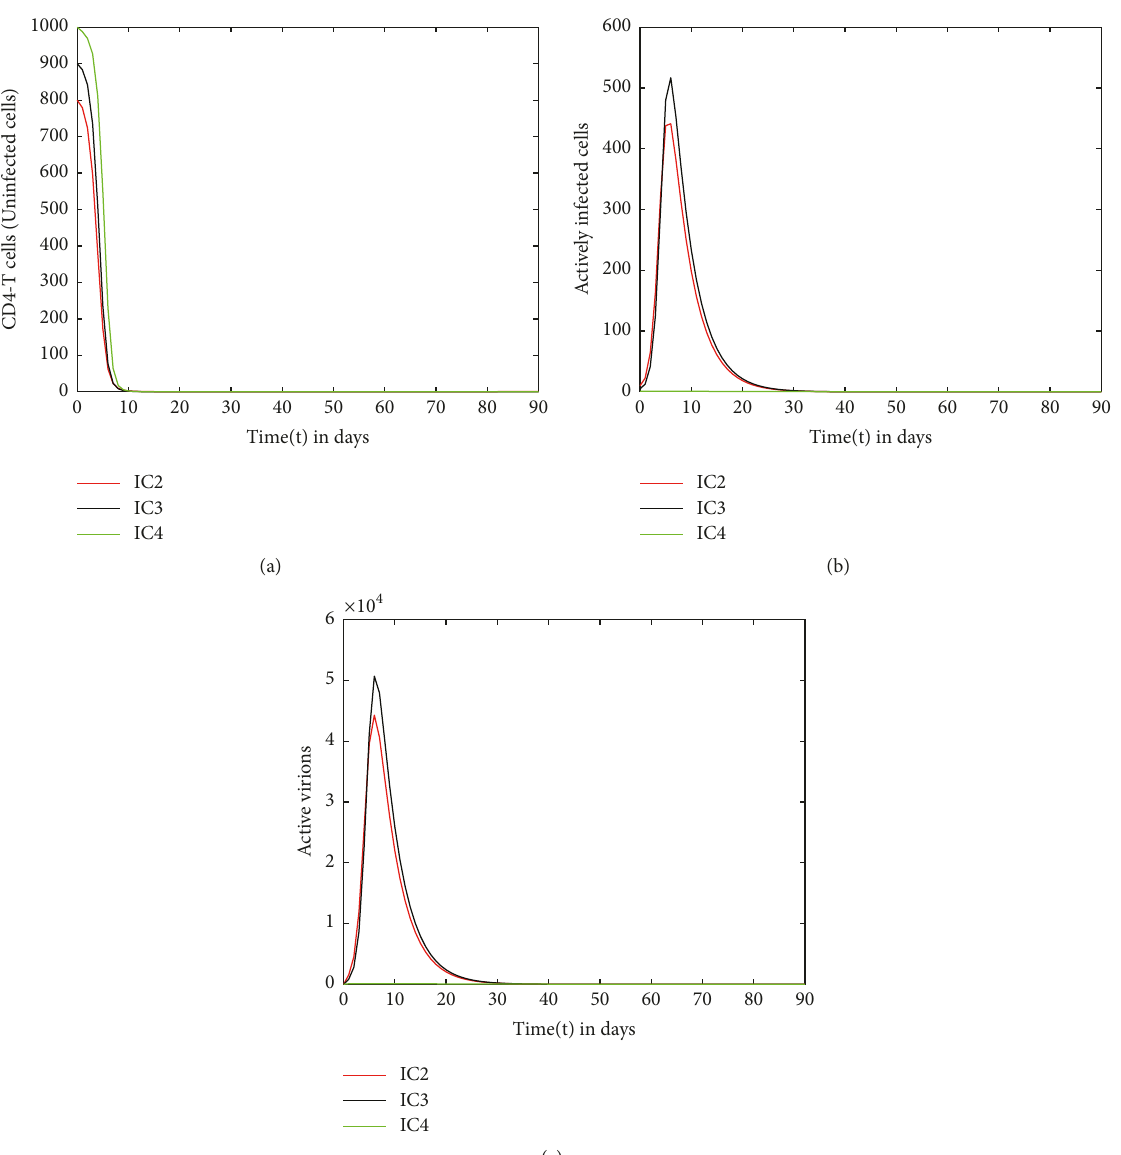
Figure 2: (a)-(c) The graph trajectory of 𝑇(𝑡) , 𝑇 ⋆ (𝑡) , and 𝑉(𝑡) for 𝜌 = 0.1 and 𝜗 = 0.1 with the initial conditions IC2-IC4. 𝑅 0 = 4.545 and 𝐸𝐸 = (110.011,3.575,357.53) is